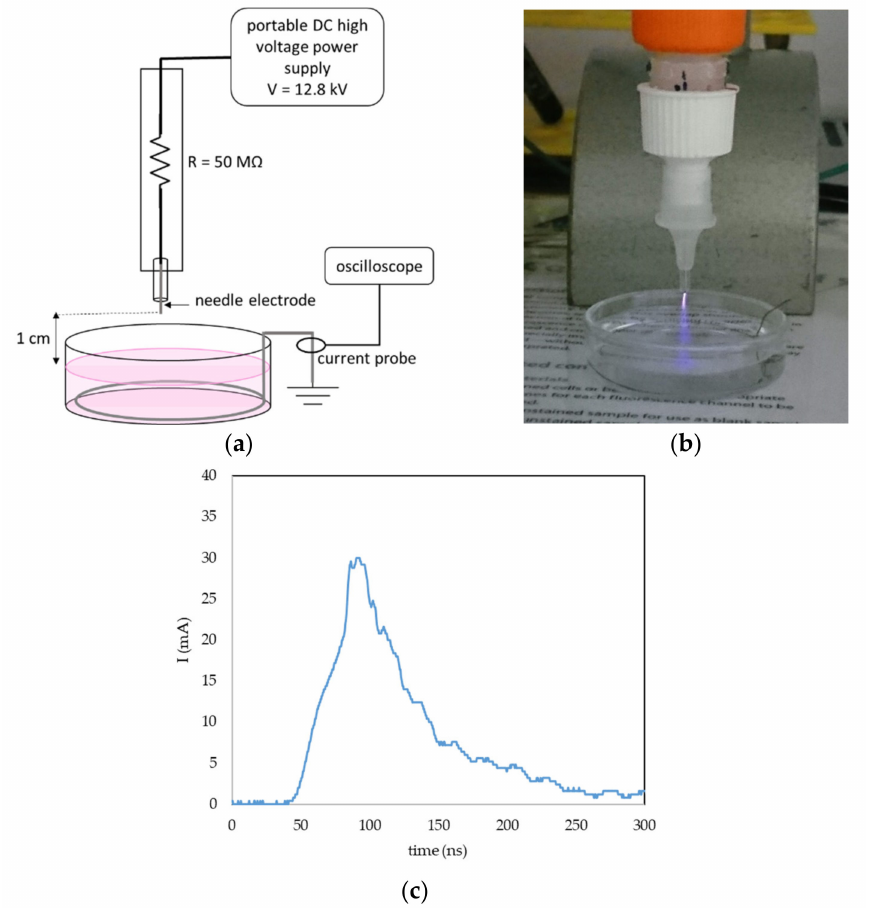
Figure 16. Streamer corona portable plasma pen in air and plasma activation of liquids. ( a ) General setup of the plasma pen in liquid activation; ( b ) photo of the PBS activation with streamer corona; and ( c ) example of one current pulse of the streamer corona discharge in the described geometry and voltage 12.8